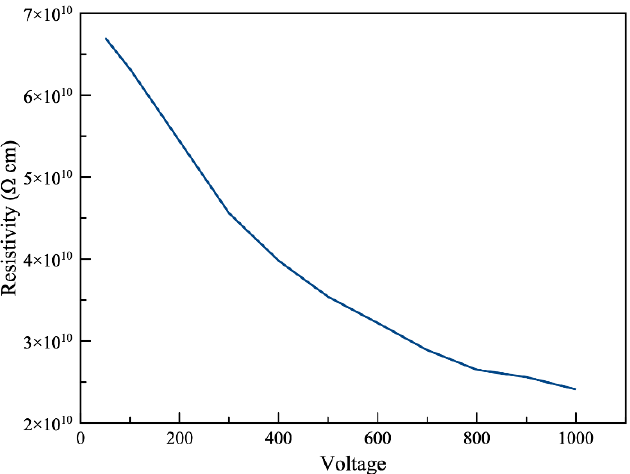
Figure 5. Volume resistivity of Viton specimen under various voltages (less than 1% error).